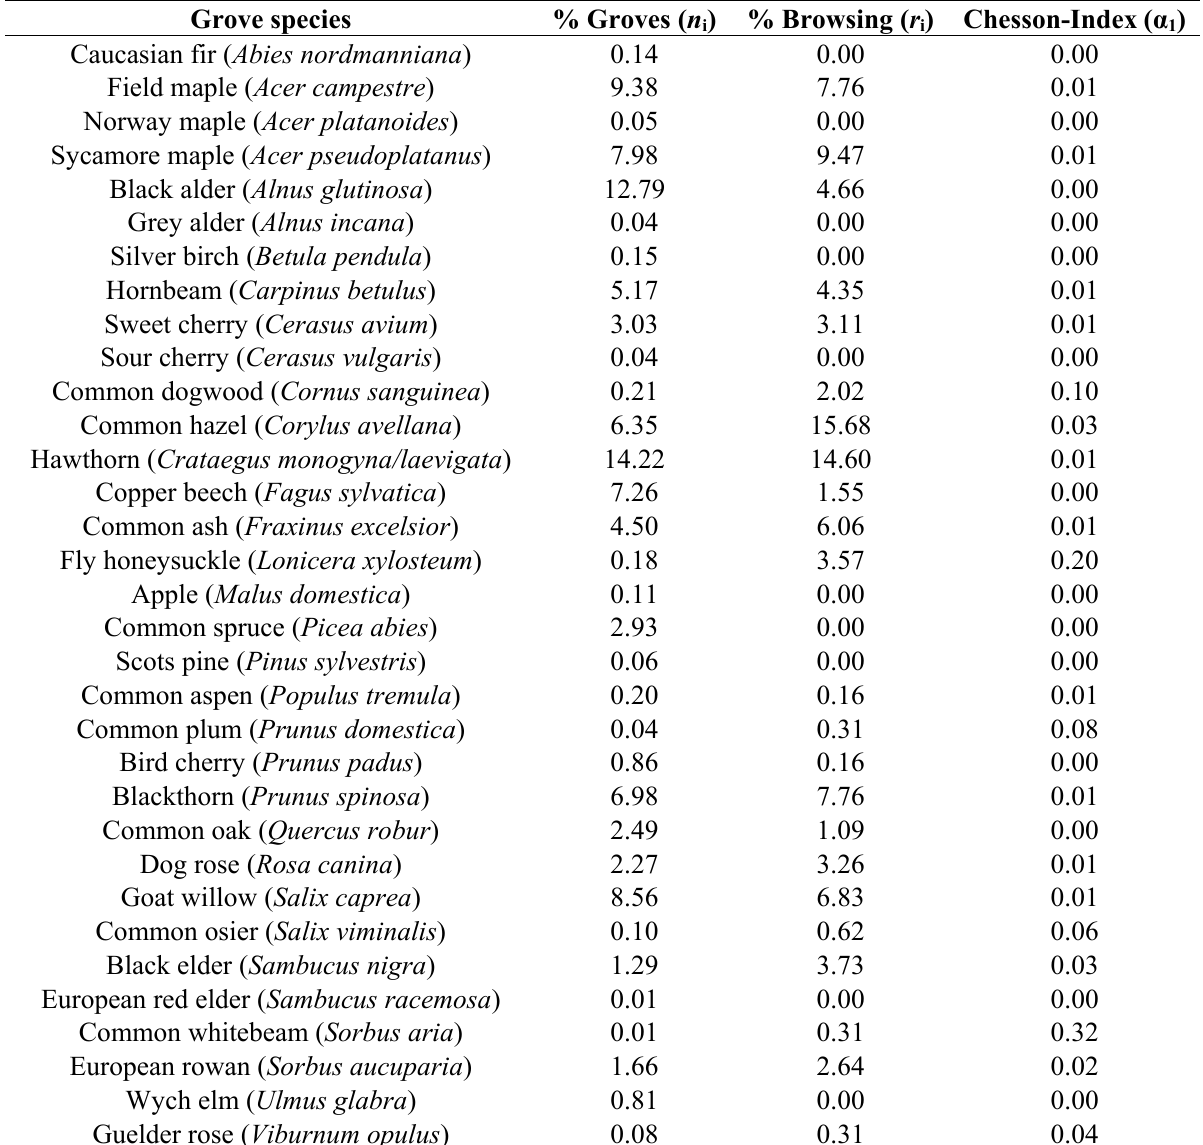
Table 2. Frequency of grove species, frequency of browsing and Chesson-Index (bold = preference) of browsing on groves in pastures of Thuringia ( n = 648). Grove species % Groves ( n